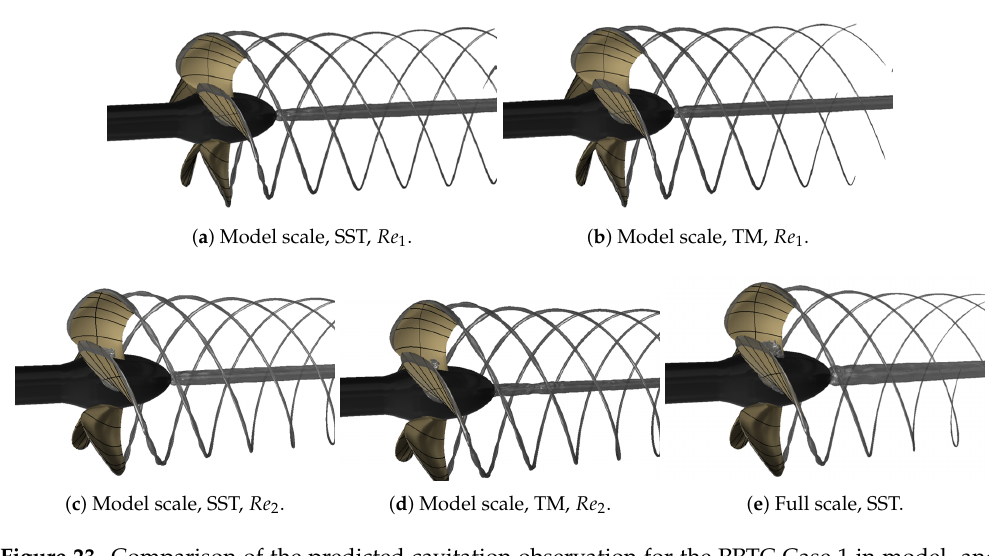
Figure 23. Comparison of the predicted cavitation observation for the PPTC Case 1 in model- and full-scale